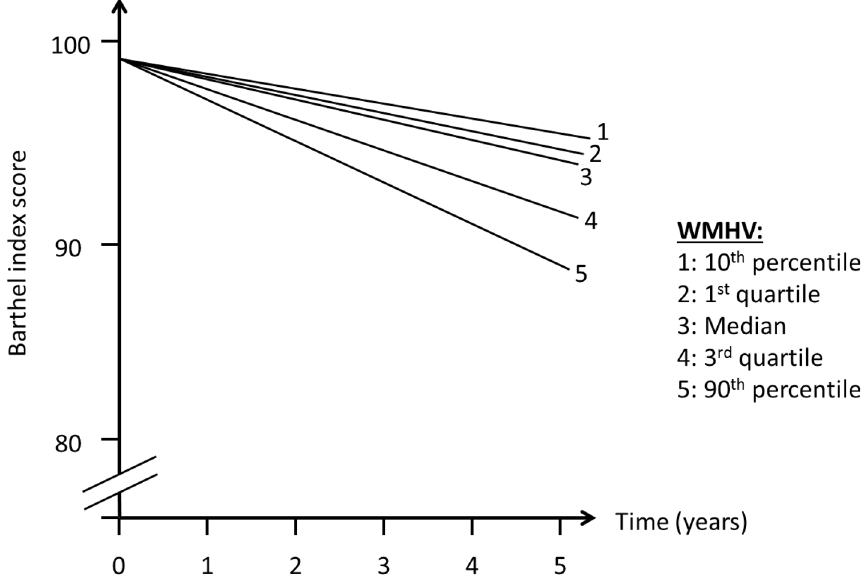
Fig 4. Estimated trajectories of functional status, by amount of white matter hyperintensity. WMHV, white matter hyperintensity volume.